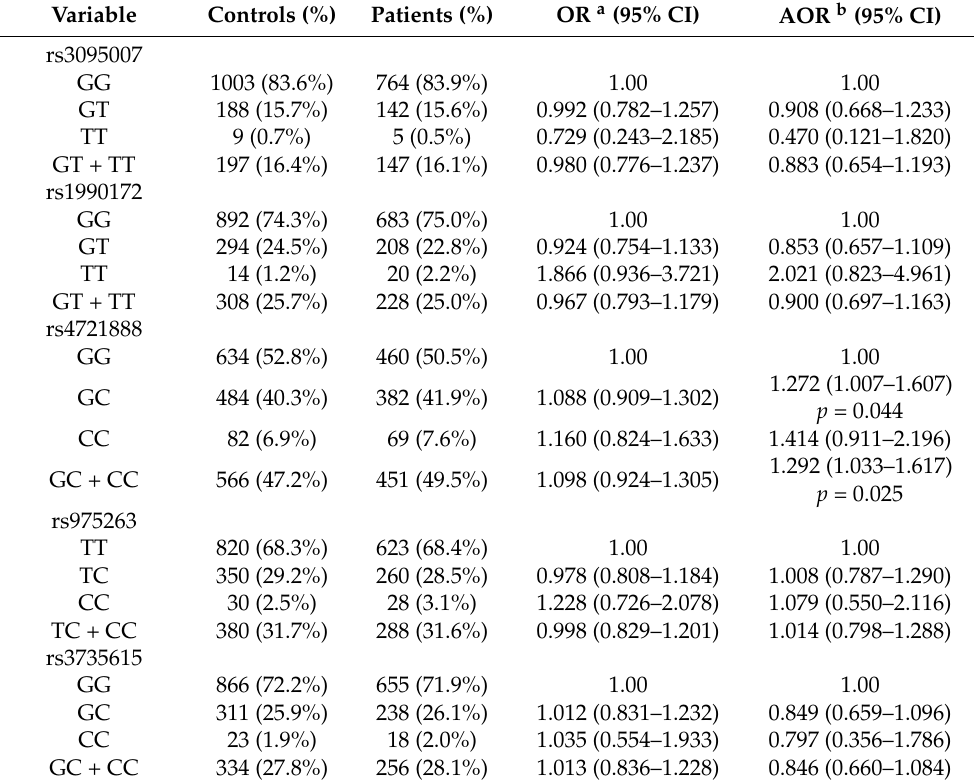
Table 2. The distribution of genotypic frequencies in MACC1 SNPs in case-control